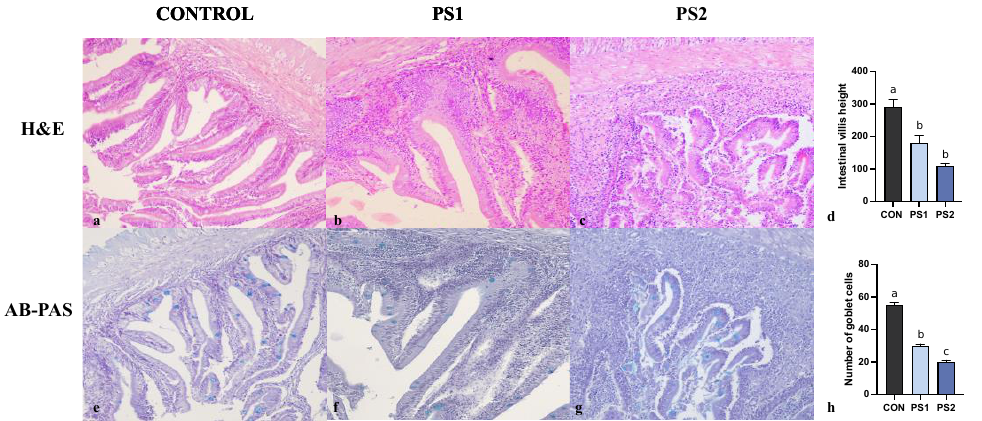
Figure 1. Representative microphotographs of anterior intestine (AI) of gilthead seabreams fed with control diet ( a , e ) and PS-MPs 25 mg/kg b.w./day ( b , f ) and 250 mg/kg b.w./day ( c , g ). Haematoxylin & eosin (H&E) staining is shown in panels ( a – c ) (original magnification, 20×). Alcian Blue-Periodic Acid Schiff’s (AB -PAS) staining is reported in panel ( e – g ) (original magnification, 20×). Panels ( d , h ) show the average of intestinal villi height ( μ m) and the number of goblet cells, respectively. All data are shown as mean ± S.E.M. Different letters indicate significant differences among treatments (at least p < 0.05).